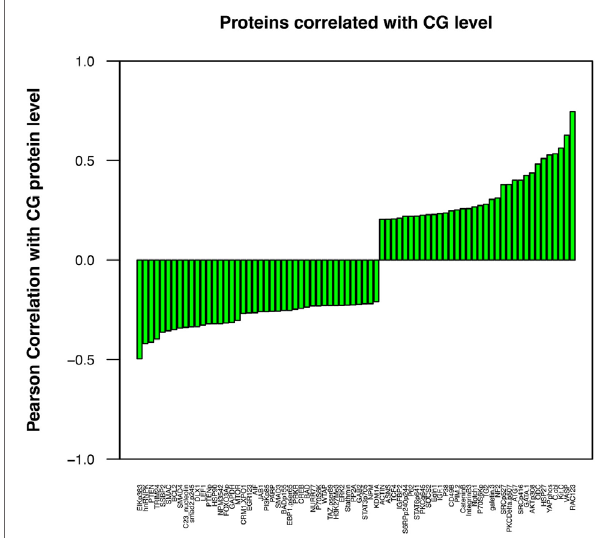
FigUre 5 | Cathepsin G (CG) protein expression correlates with the concurrent expression of known leukemia-associated proteins. Pearson correlation coefficient analysis was performed to determine the association between the levels of CG and various selected proteins that are known to contribute to leukemogenesis and progression of ALL. These proteins were identified with a correlation coefficient threshold of 0.2. These proteins were assessed for both co-occurrence and inverse correlation with CG1; cell adhesion molecules TG2 and ITGB3, oncogene C-kit, proliferation- associated protein GATA1, and vascular protein VASP were among the proteins expressed at highest levels in association with CG, while tumor suppressor protein PTEN, apoptotic proteins SMAC and BCL2, and differentiation-promoting protein SSBP2 were expressed at low levels. All proteins were identified with a correlation coefficient threshold of